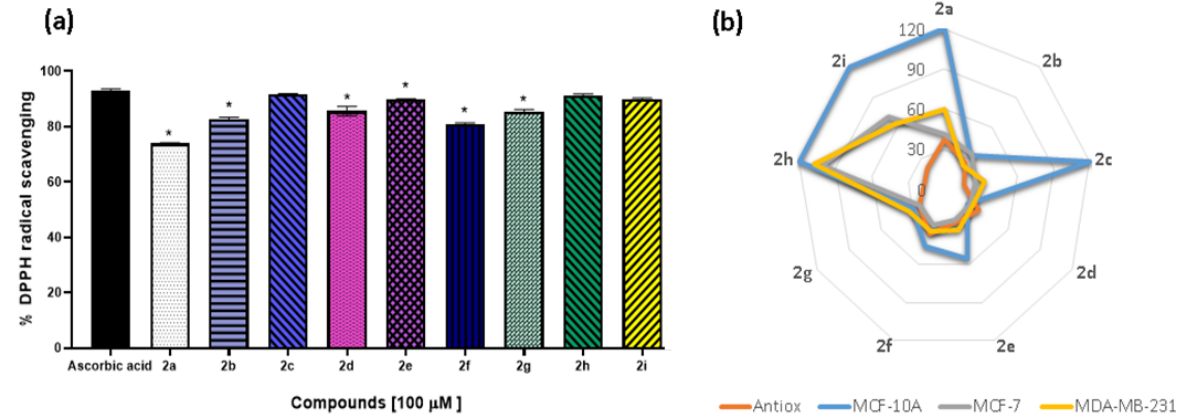
Figure 7. ( a ) DPPH radical scavenging activity of compounds 2a–i vs ascorbic acid (AA) at 100 µM. Data represent mean ± SEM [* significantly different from AA ( p < 0.05)]. The assays were performed in triplicate. Antioxidant IC 50 values ( µ M): 38 ± 3 ( 2a ), 26 ± 2 ( 2b ), 16 ± 4 ( 2c ), 32 ± 3 ( 2d ), 26 ± 2 ( 2e ), 35 ± 3 ( 2f ), 23 ± 3 ( 2g ), 17 ± 3 ( 2h ), 21 ± 2 ( 2i ), and 13 ± 2 ( AA ). ( b ) Comparative graph between the antioxidant and antiproliferative (MCF-10A, MCF-7 and MDA-MB231 cell lines) IC 50 values (radial axis) of compounds 2a–i (periphery).